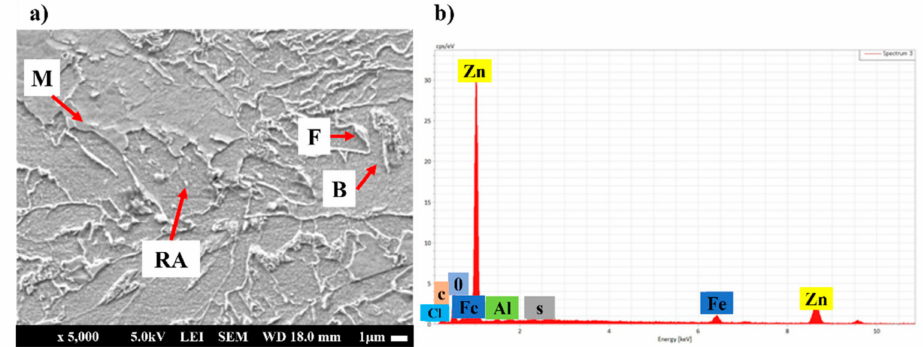
Figure 4. SEM observation. ( a ) microstructure of the BM and ( b ) EDS